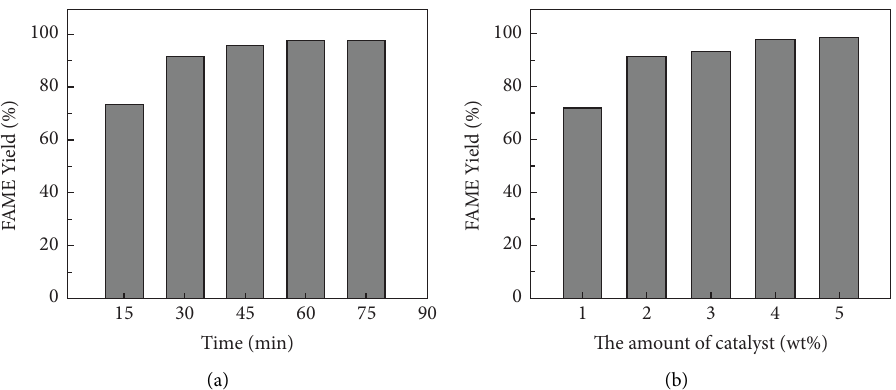
Figure 6: Efect of diferent catalyst preparation conditions on FAME yield: (a) reaction time and (b) the amount of catalyst. Reaction conditions: 338 K and alcohol-oil ratio